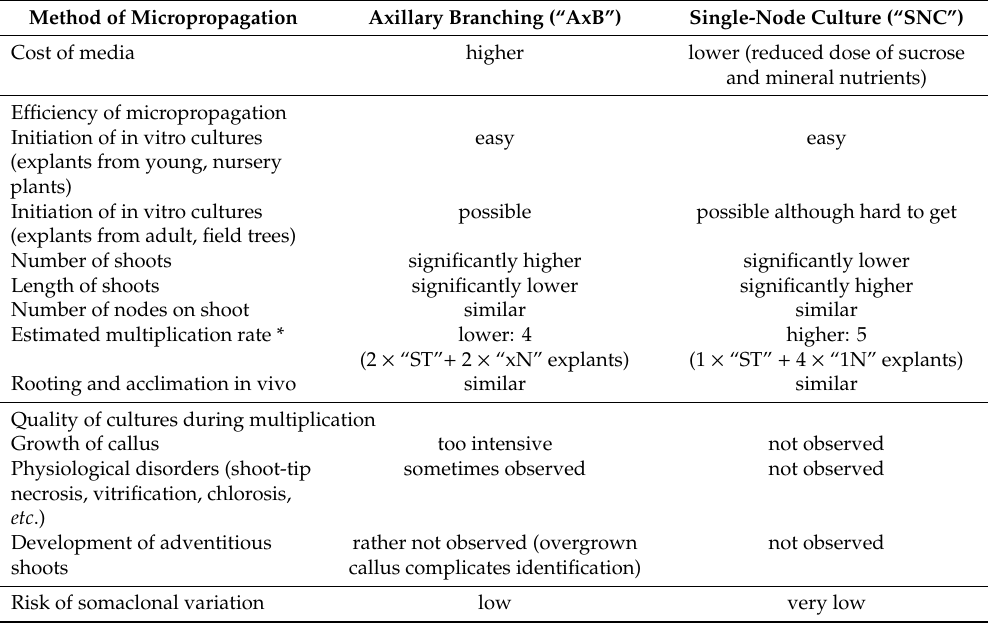
Table 9. Comparison of two methods of mountain mulberry propagation through in vitro shoot cultures.